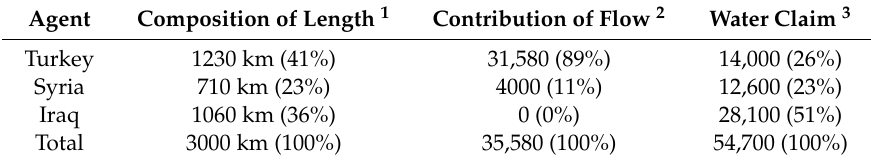
Table 1. The contribution and claim (MCM / year) of the three countries in the Euphrates River Basin. Agent Composition of Length 1 Contribution of Flow 2 Water Claim 3 Turkey 1230 km (41%) 31,580 (89%) 14,000 (26%) Syria 710 km (23%) 4000 (11%) 12,600 (23%) Iraq 1060 km (36%) 0 (0%) 28,100 (51%) Total 3000 km (100%) 35,580 (100%) 54,700